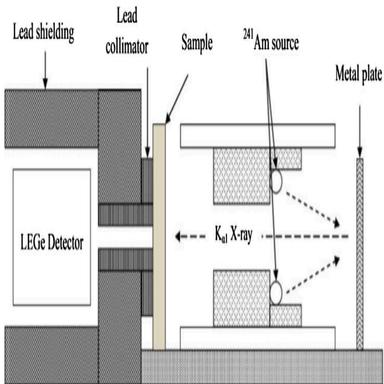
Schematic diagram of the XRF configuration method for the measurement of linear and mass attenuation coefficient of the particleboards.